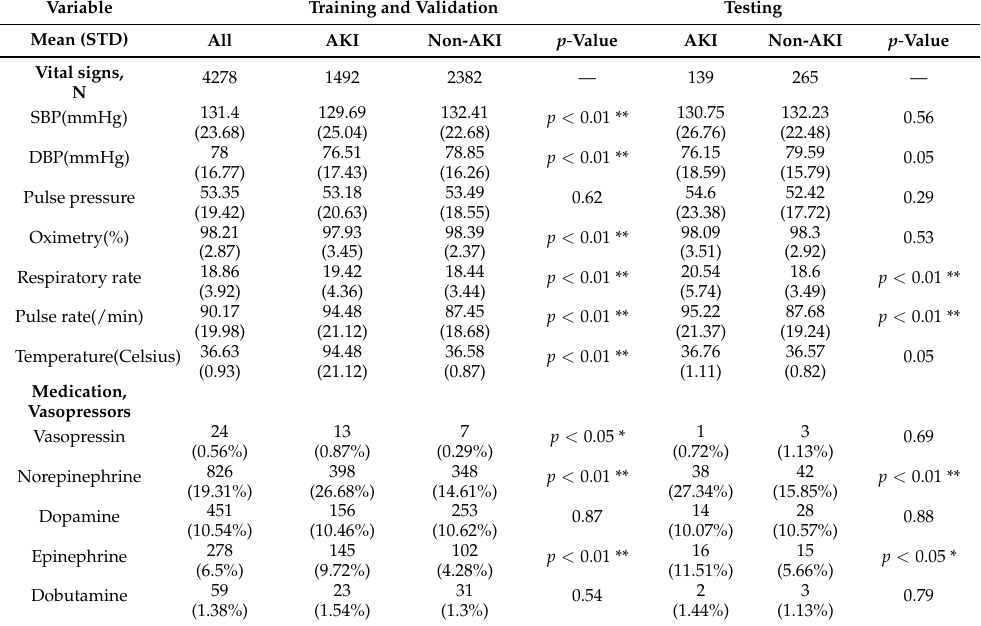
Table 6. Cohort Analysis of Vital Signs and Medications.